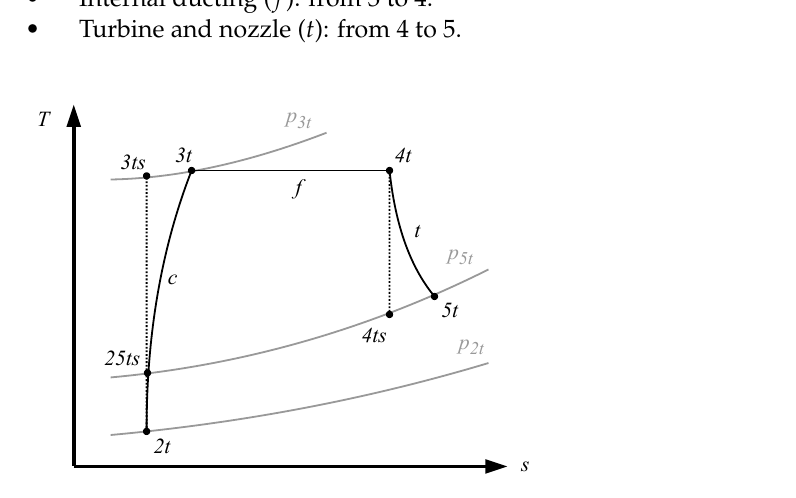
Figure 8. T − s diagram showing the thermodynamic evolution of the internal flow of the capsule. In this diagram, the intake is the station 2 and the nozzle exhaust is the station